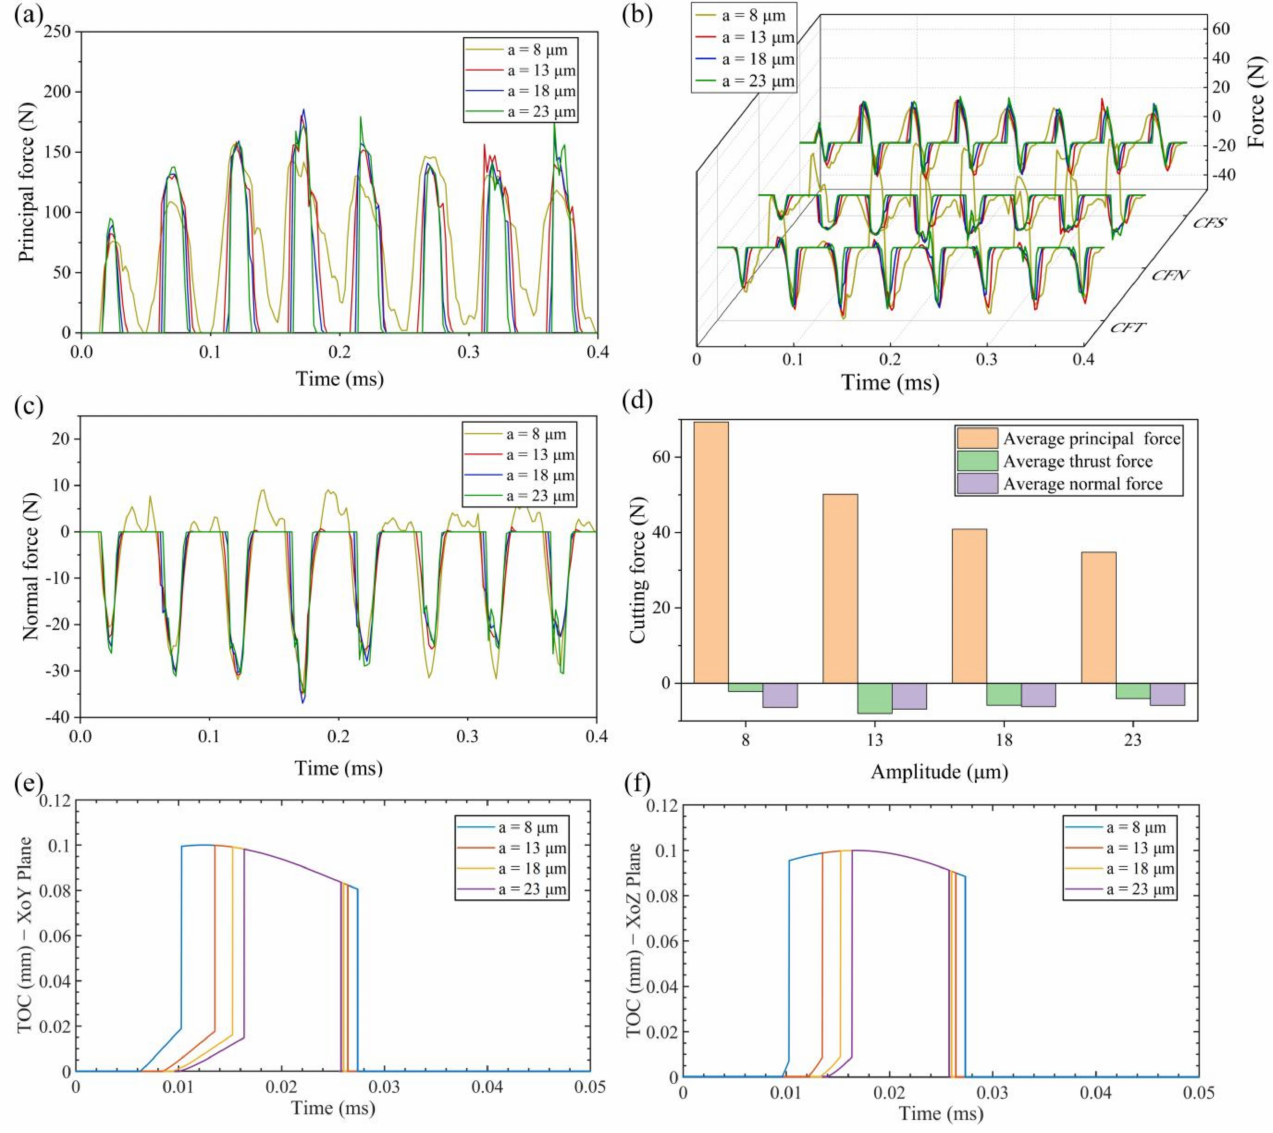
Figure 6. Results of cutting force and TOC with various amplitudes a ( a ) principal force ( b ) thrust force ( c ) normal force ( d ) average cutting force ( e ) TOC with various amplitudes a in XoY plane ( f ) TOC with various amplitudes a in XoZ